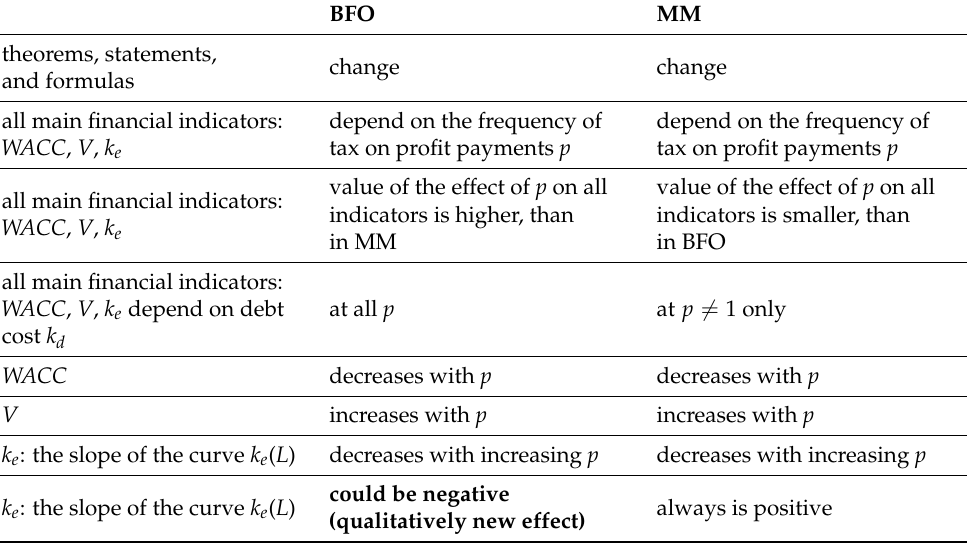
Table 8. Comparison of the impact of the frequency of income tax payments in BFO theory and in MM theory. BFO